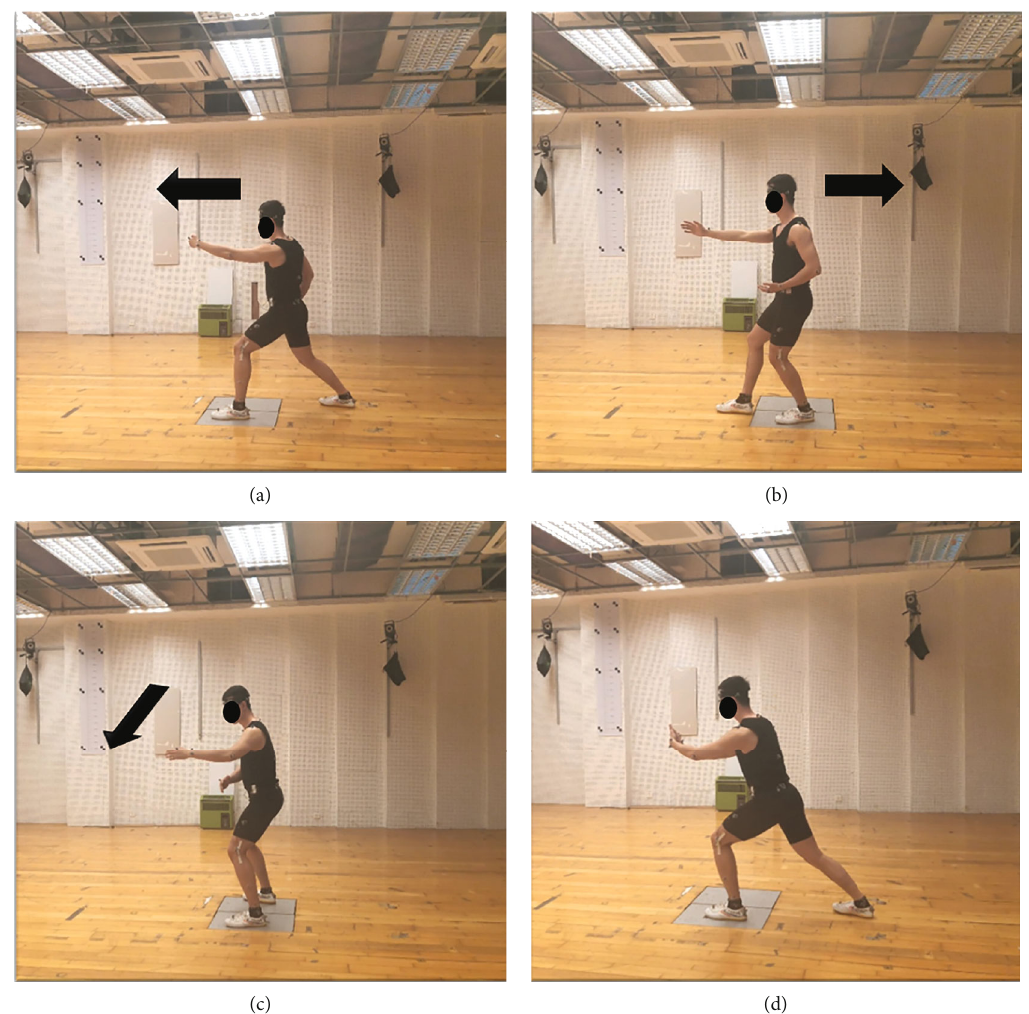
Figure 1: Lateral view of forward step: wild horse ’ s mane (a); backward step: repulse monkey (b); sidestep: wave-hand in cloud (c); middle standing: grasp the bird ’ s tail (d). The arrow indicates the direction of